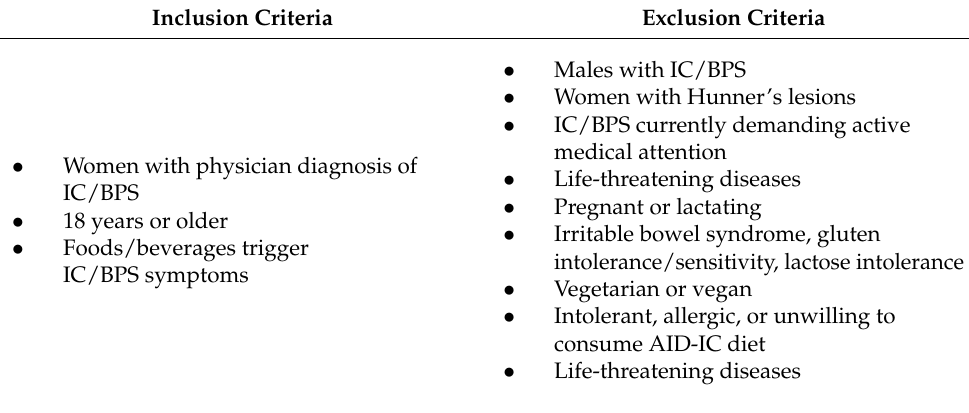
Table 1. Inclusion and exclusion criteria for AID-IC pilot study. Inclusion